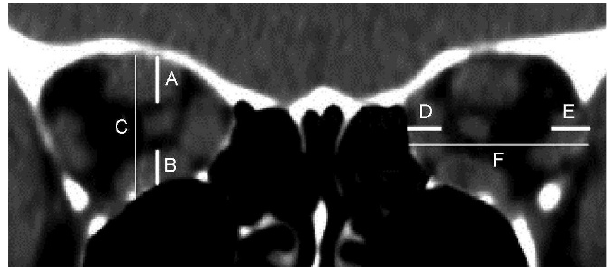
Figure 5 - Schematic representation of the method for calculat- ing Barrett’s muscle index. The vertical index was calculated by the sum of the vertical muscle diameters (A and B) divided by the height of the orbit (C). The horizontal index was calculated by dividing the sum of the horizontal muscle diameters (D and E) by the horizontal diameter of the orbit (F).